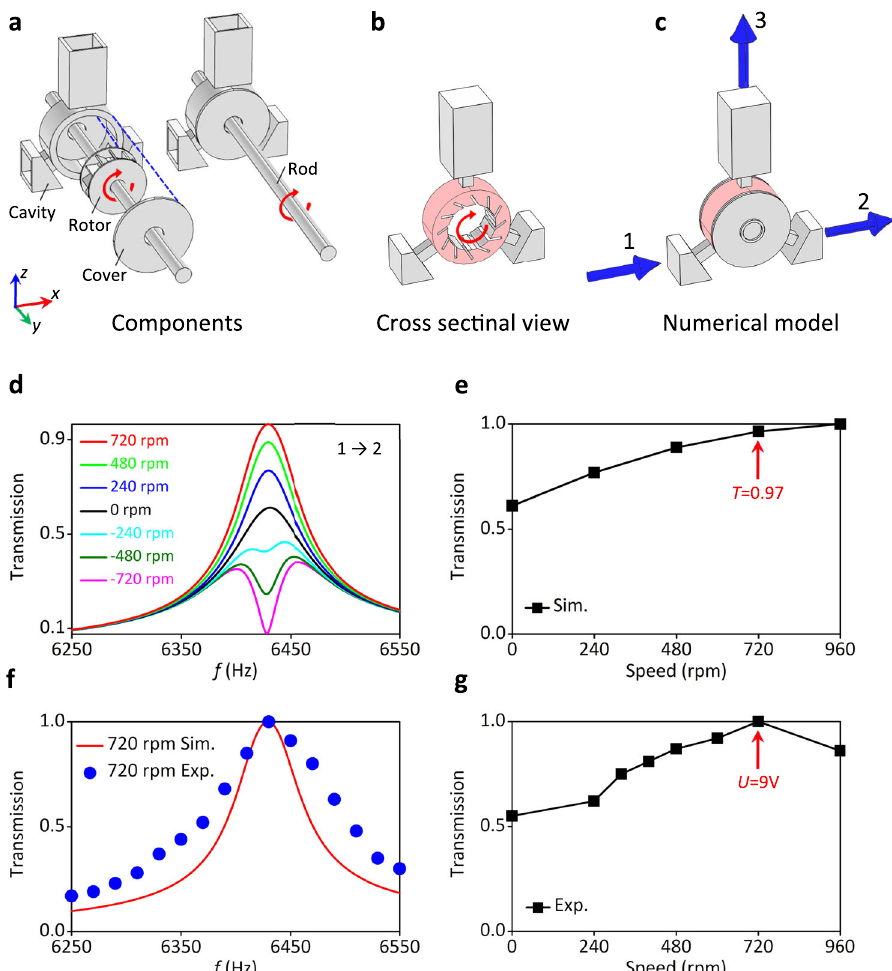
Fig. 2 Design of the acoustic circulator. a Schematic diagram of the single acoustic circulator consisting of cavity, rotor, cover, and rotating rod as marked in the fi gure. b The cross sectional view of the circular. c The physical model for the numerical simulation of the circulator. The three ports (ports 1 – 3) are marked by blue arrows. d The simulated transmissions from port 1 to port 2 for the single circulator with different rotation speeds n = ±720 rpm, n = ±480 rpm, n = ±240rpm, and n = 0 rpm. The maximum and minimum of transmission appear at 6430 Hz with n = + 720 rpm and n = − 720 rpm, respectively. e The simulated transmission as function of the rotation speed. At the optimized rotation speed n = 720 rpm, the transmission is of about 0.97. f The simulated (Sim., n = 720 rpm) and experimental (Exp., n = 720 rpm) transmissions around 6430 Hz. g The experimental transmission as function as the rotation speed. The maximum transmission is reached at n = 720 rpm, corresponding to the motor voltage of U = 9